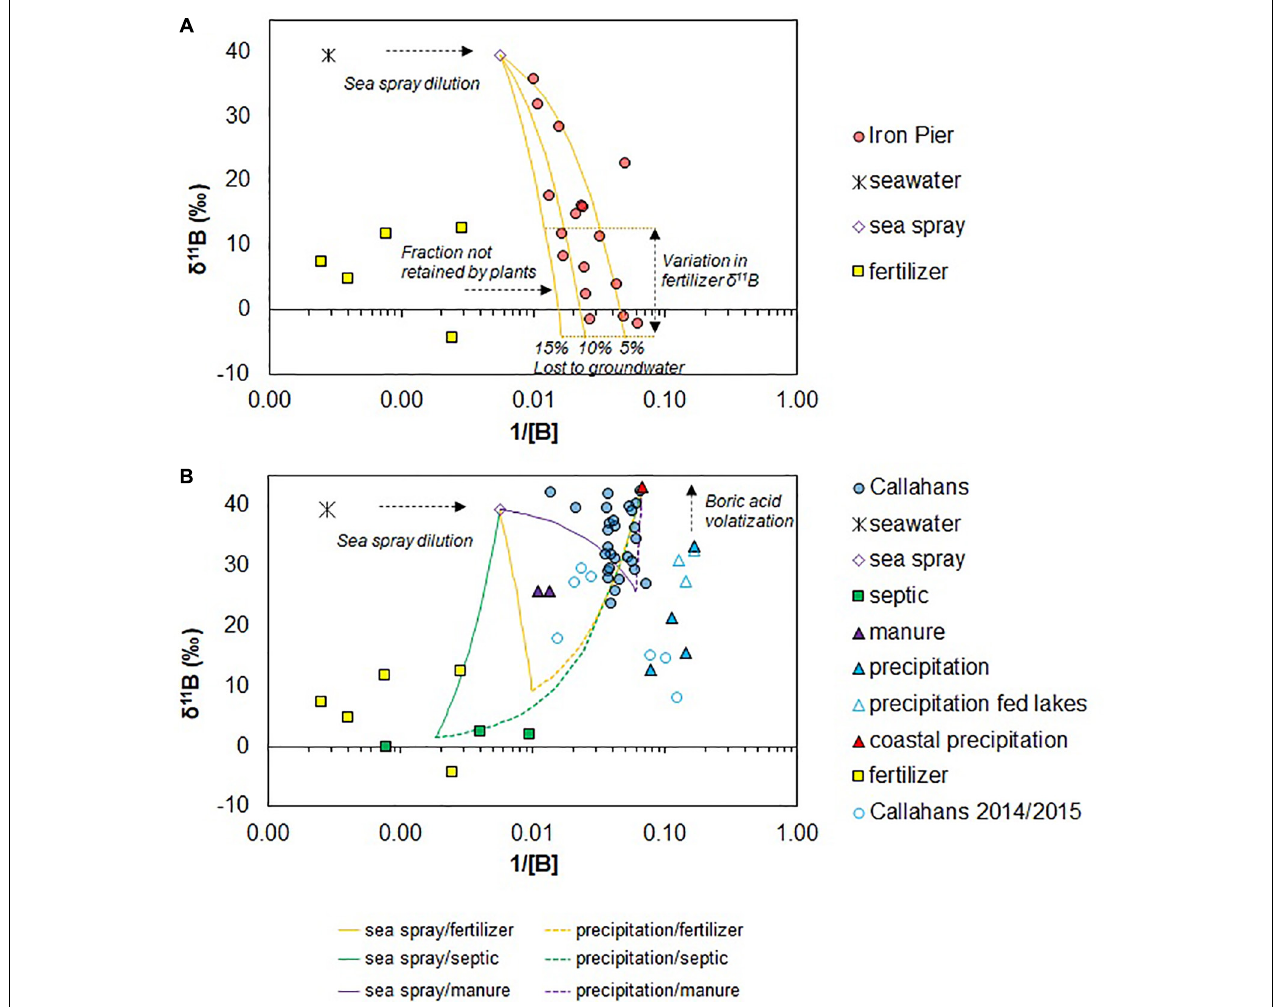
FIGURE 6 | Log of 1/B vs. δ 11 B of coastal groundwater samples from Iron Pier Beach (A) and Callahans Beach (B) . In panel (A) , theoretical mixing between sea spray and fertilizer (orange curves) assumes that sea spray constitutes 5% of the B concentration of seawater, and that B retention from plants is between 85 and 95% of the applied fertilizer load. The horizontal orange dashed lines indicate the range of fertilizer δ 11 B (MilorganiteTM [ –